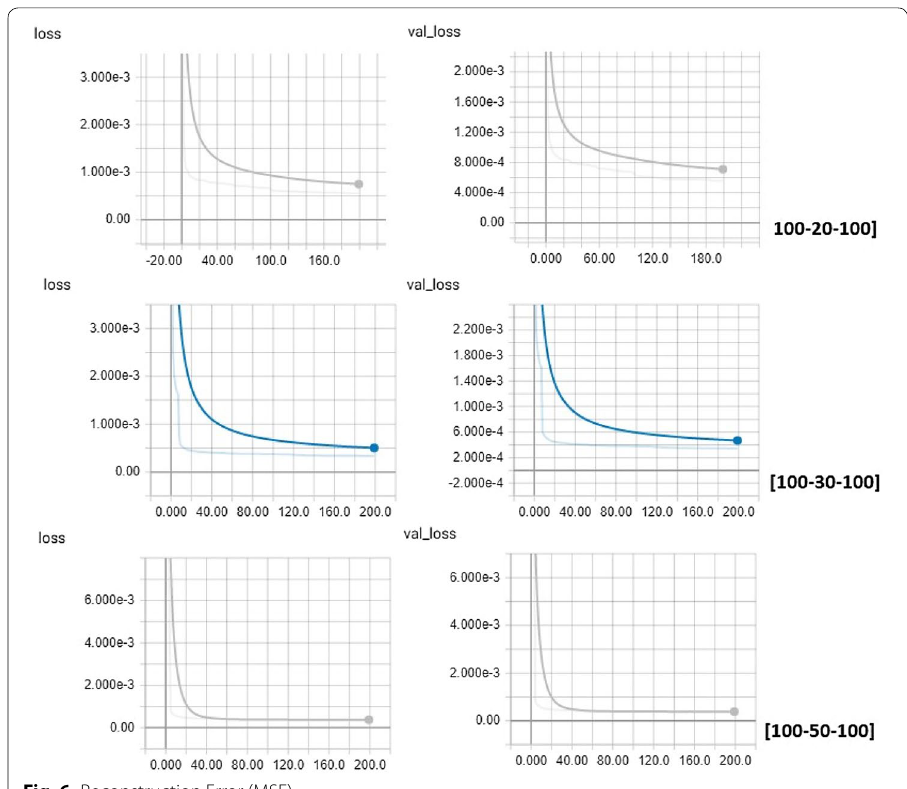
Fig. 6 Reconstruction Error